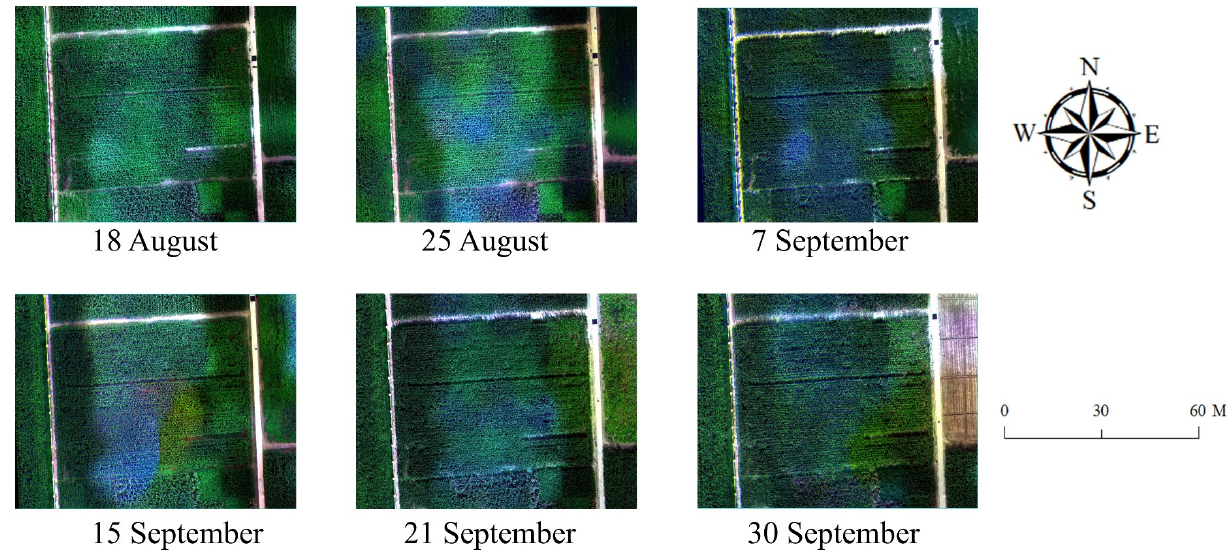
Remote Sens. 2022 , 14 , 1337 Figure 3. The subtracted multi-spectral images of different growth stages of maize shown in RGB color system. Note: the fonts under the images are the date of data acquisition.